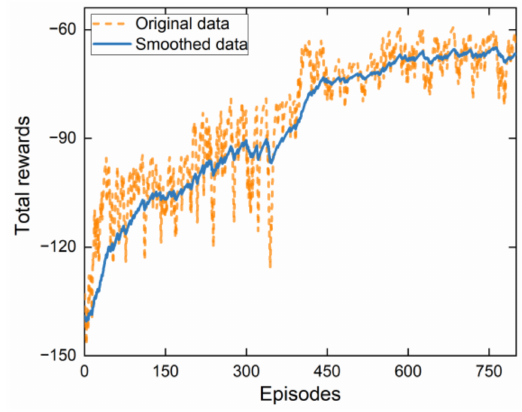
Figure 5. RL algorithm training reward